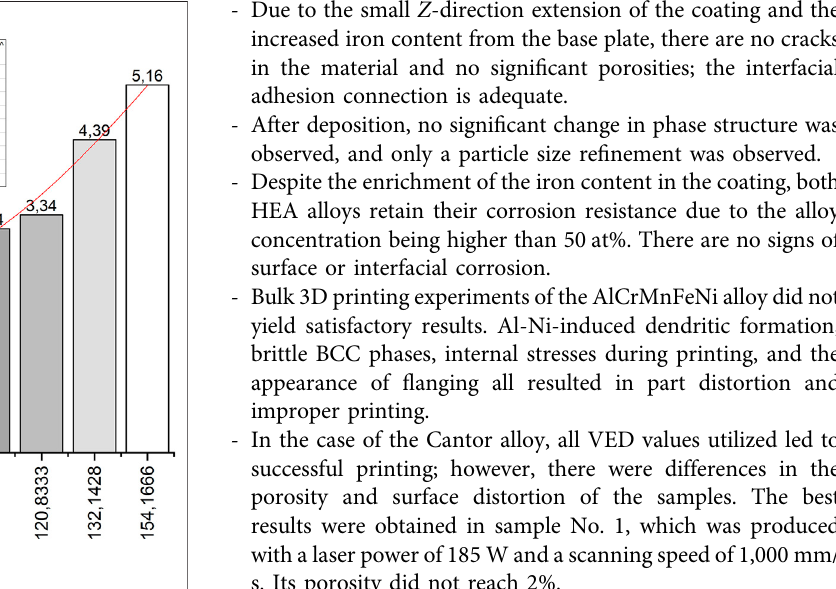
Frontiers in Materials |